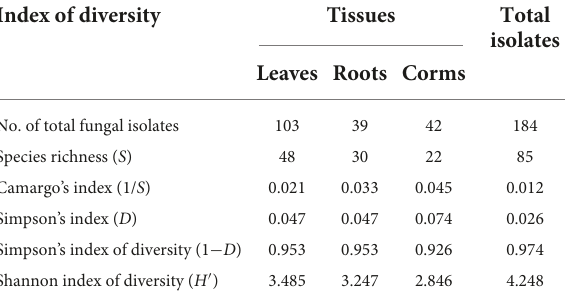
TABLE 1 The diversity of culturable endophytic fungi isolated from the health tissues of Nervilia fordii . Index of